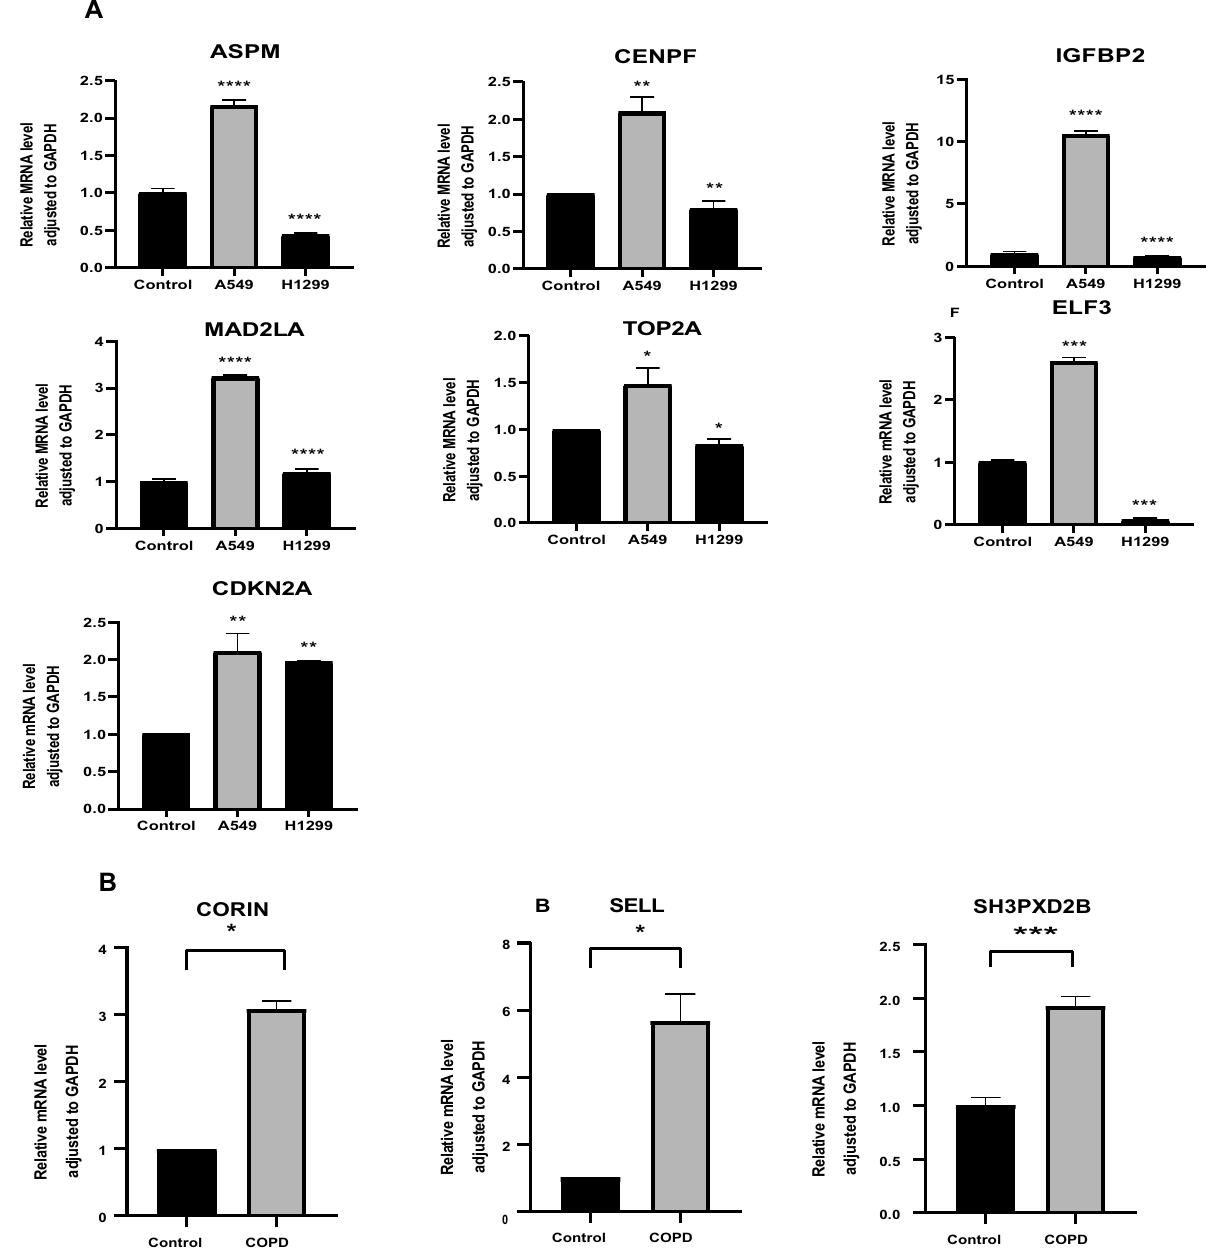
Figure 6. ( A ), RT–qPCR was used to detect the expression of different genes in LUAD and normal cells. ( B ), RT–qPCR was used to detect the expression of different genes in COPD and normal cells. “*” p < 0.05, “**” p < 0.01, “***” p < 0.001. COPD: chronic obstructive pulmonary disease; LUAD: lung adenocarcinoma; RT-qPCR: Real-time quantitative reverse transcription